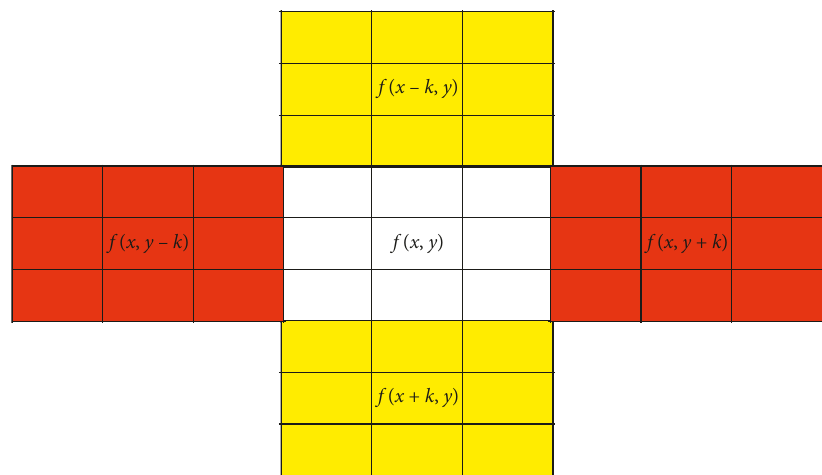
Figure 1: The anisotropic gradient image of the t -th